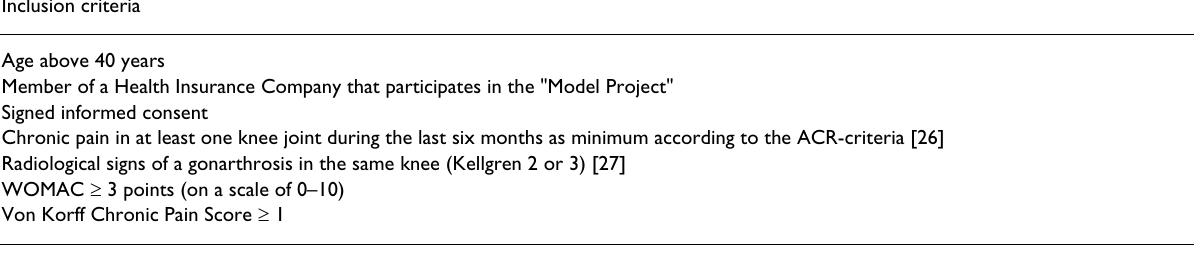
Table 1: Eligibility criteria Inclusion